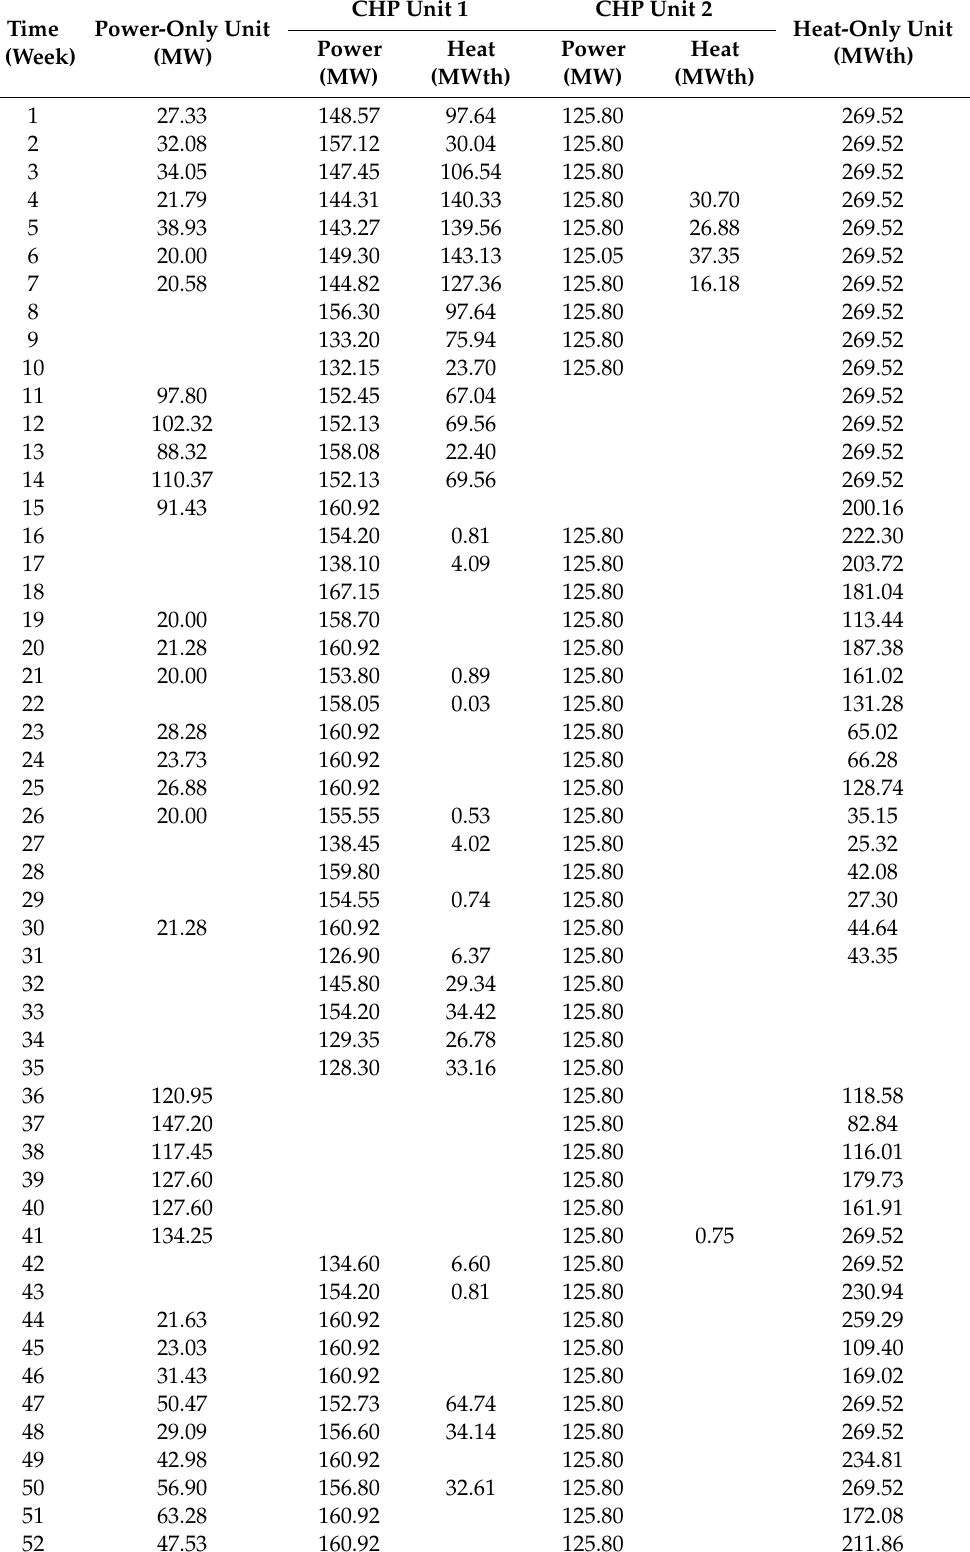
Table 4. Optimal generation of the